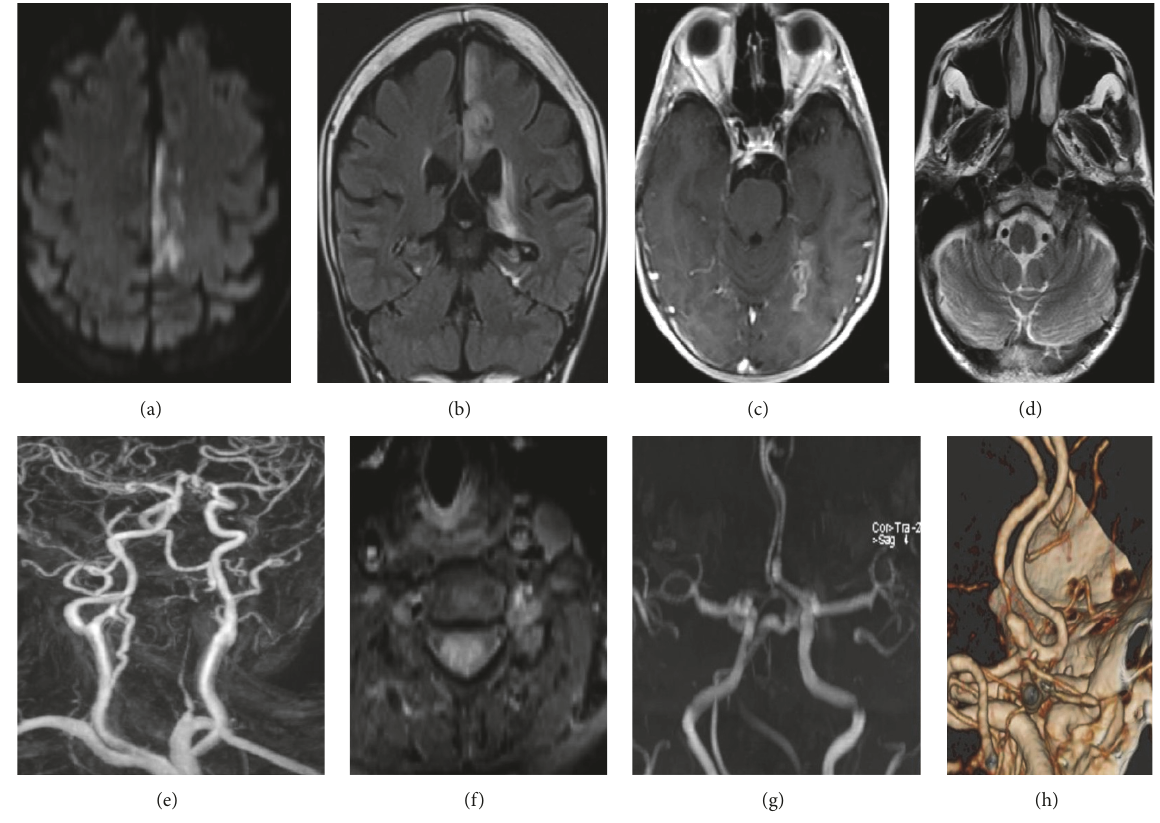
Figure 1: DWI showing (a) left acute anterior cerebral artery infarction and subacute posterior cerebral artery infarction in coronal FLAIR and (b) in postcontrast axial T1A (c); V4 segments of the vertebral arteries with a symmetrical appearance (d). Luminal narrowing along the left V2 in contrast-enhanced cervical MRA (e); hyperintensity in left V2 suggestive of intraluminal or intramural thrombus in fat-suppressed T1A (f); dissection presenting with narrowing and dilatation at the proximal part of the left A2 at 3D-TOF MRA (g) and volume rendering CTA (h). CTA was considered to be suggestive of dissected left V2, and the hyperintensity in T1A images was explained on the basis of intramural thrombus